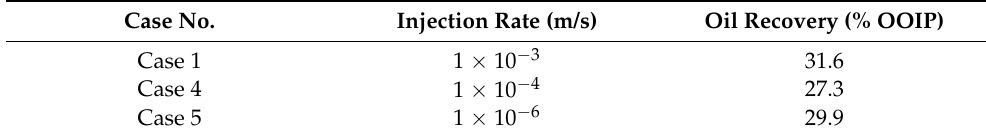
Table 4. Oil recovery for different injection